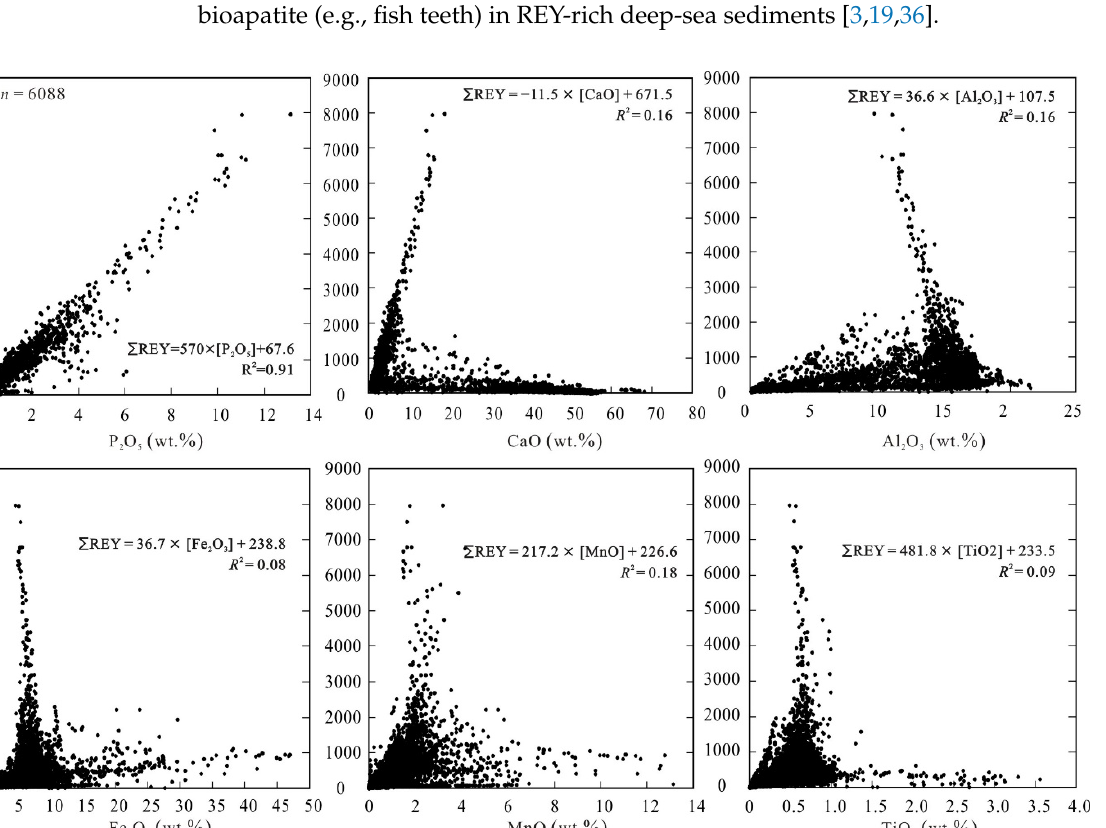
Figure 4. Relationship between the Σ REY and the major oxides of samples at each layer at site KR13 ‐ 02 PC05; data are from [9]. The units for ∑ REY are ppm; the units for oxides are weight percentage. The curves of Σ REY, CaO, and P 2 O 5 content are highly variable, showing obvious positive correlations.